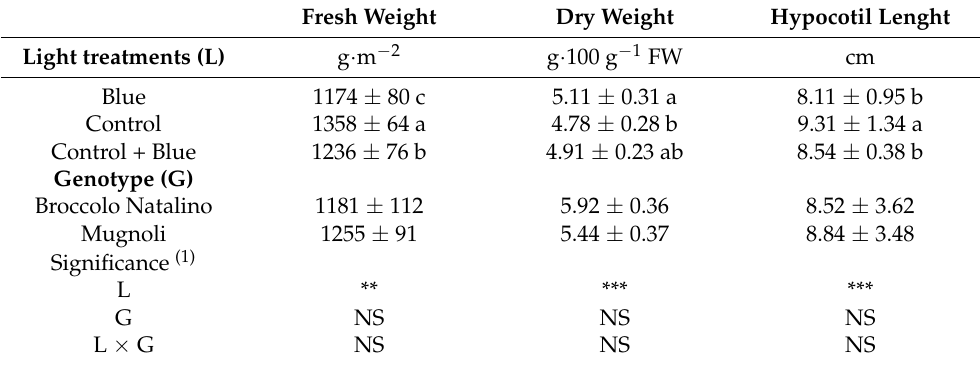
Table 3. Fresh weight, dry weight, and hypocotyl length of two Brassica microgreens (Broccolo Natalino and Mugnoli) cultivated in a growth chamber with three different light spectra: Blue (B), Control (CTRL), and Control + Blue (CTRL + B). Means followed by different letters within a column indicate significant differences according to Student–Newman–Keuls (SNK) test at p = 0.05.